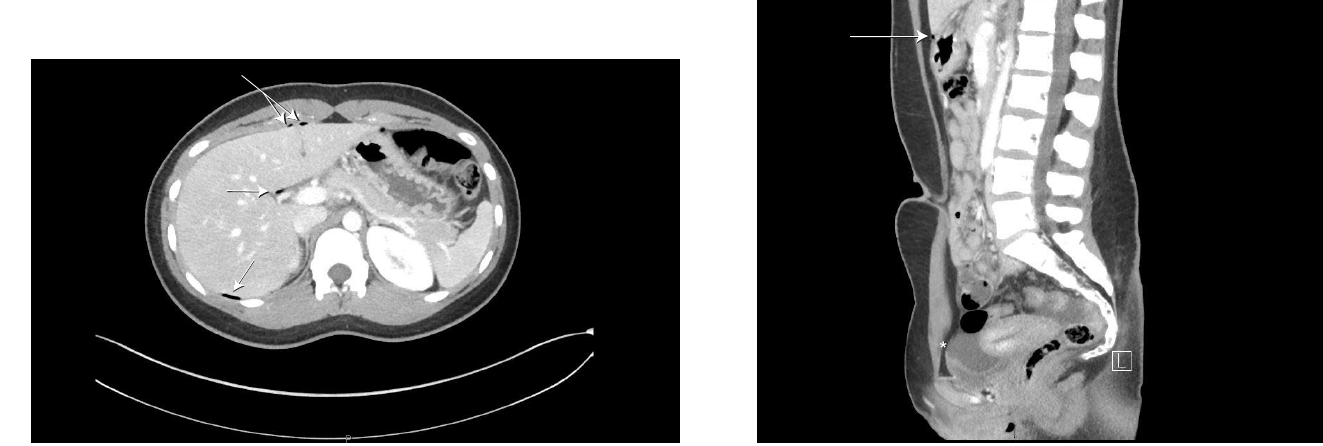
Image 2. Sagittal CT image demonstrating free air (arrows) and free fluid (asterisk) in